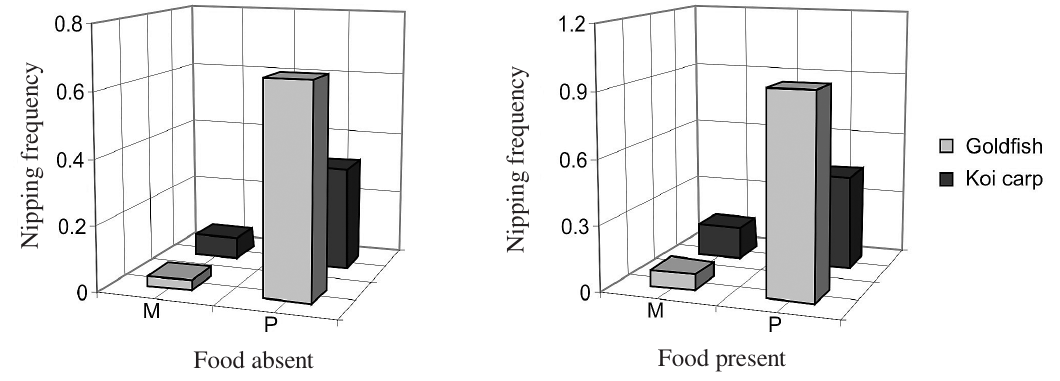
Fig. 4. Standardised (per capita) nipping frequency per trial estimated for koi carp and goldfish under monoculture (M) and poly- culture (P) conditions in aquaria in the presence and absence of food (plankton)